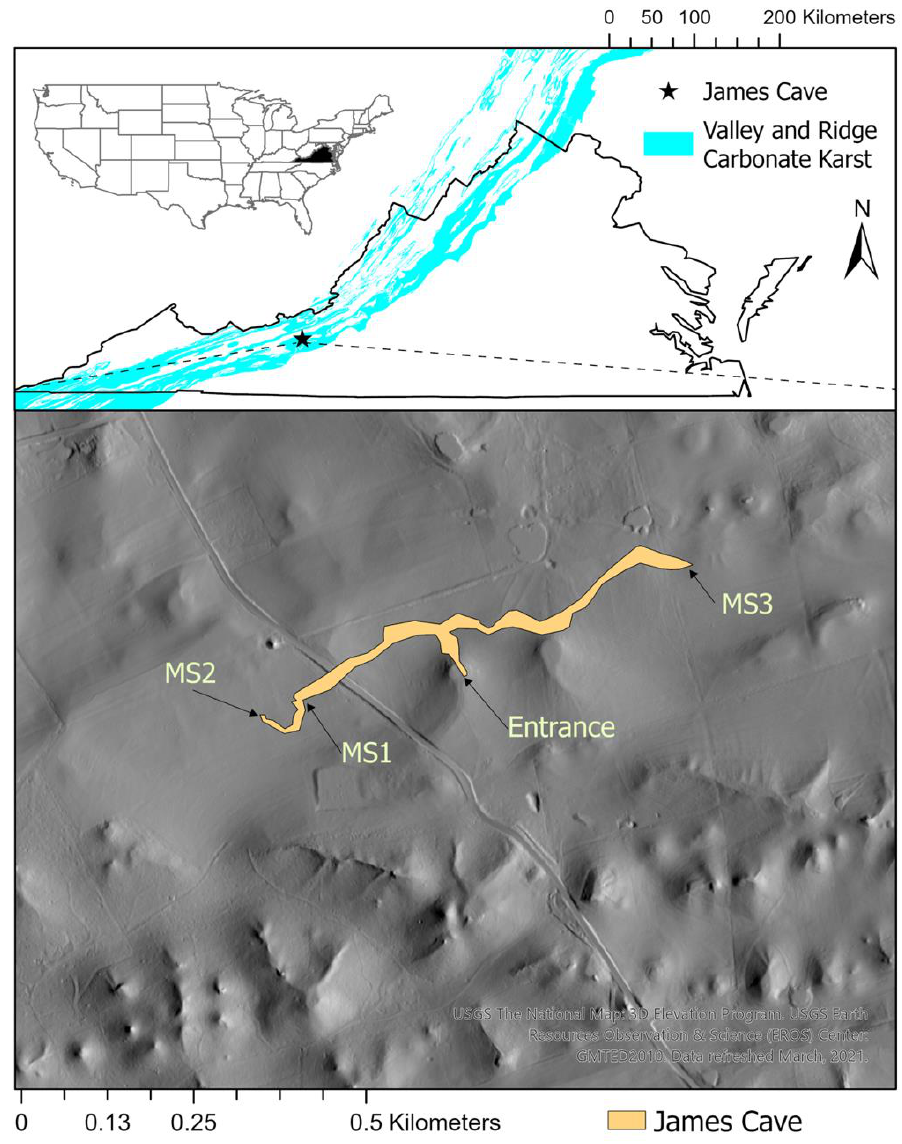
Figure 1. Top: Location of James Cave in Pulaski County, Virginia, USA, overlain by valley and ridge karst map [42]. Bottom: One-meter digital elevation model of the area surrounding James Cave [43], overlain by a cave survey produced by Tom Malabad. MS = location of drip monitoring station within the cave.